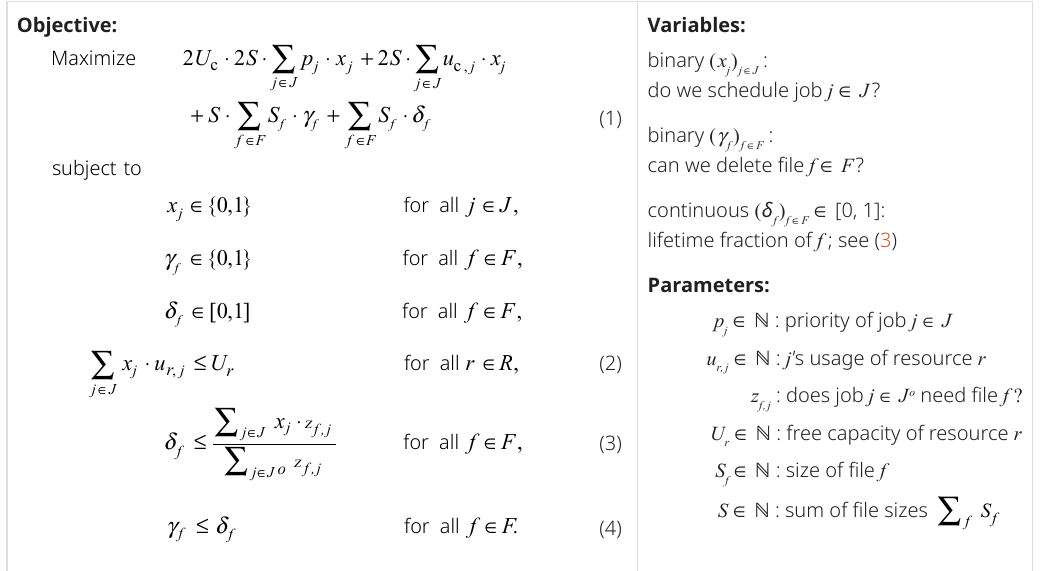
Table 1. Mixed integer linear program for Snakemake’s scheduling